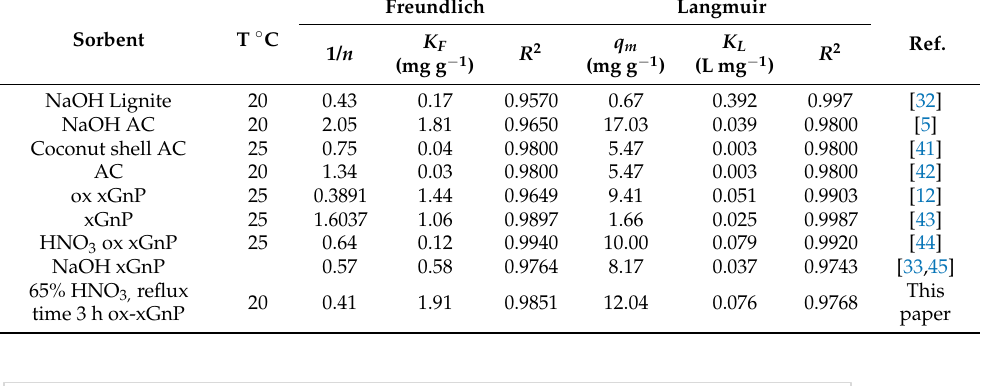
Table 5. A comparison of isotherm parameters of Freundlich and Langmuir models for NH 4+ adsorption from the literature.